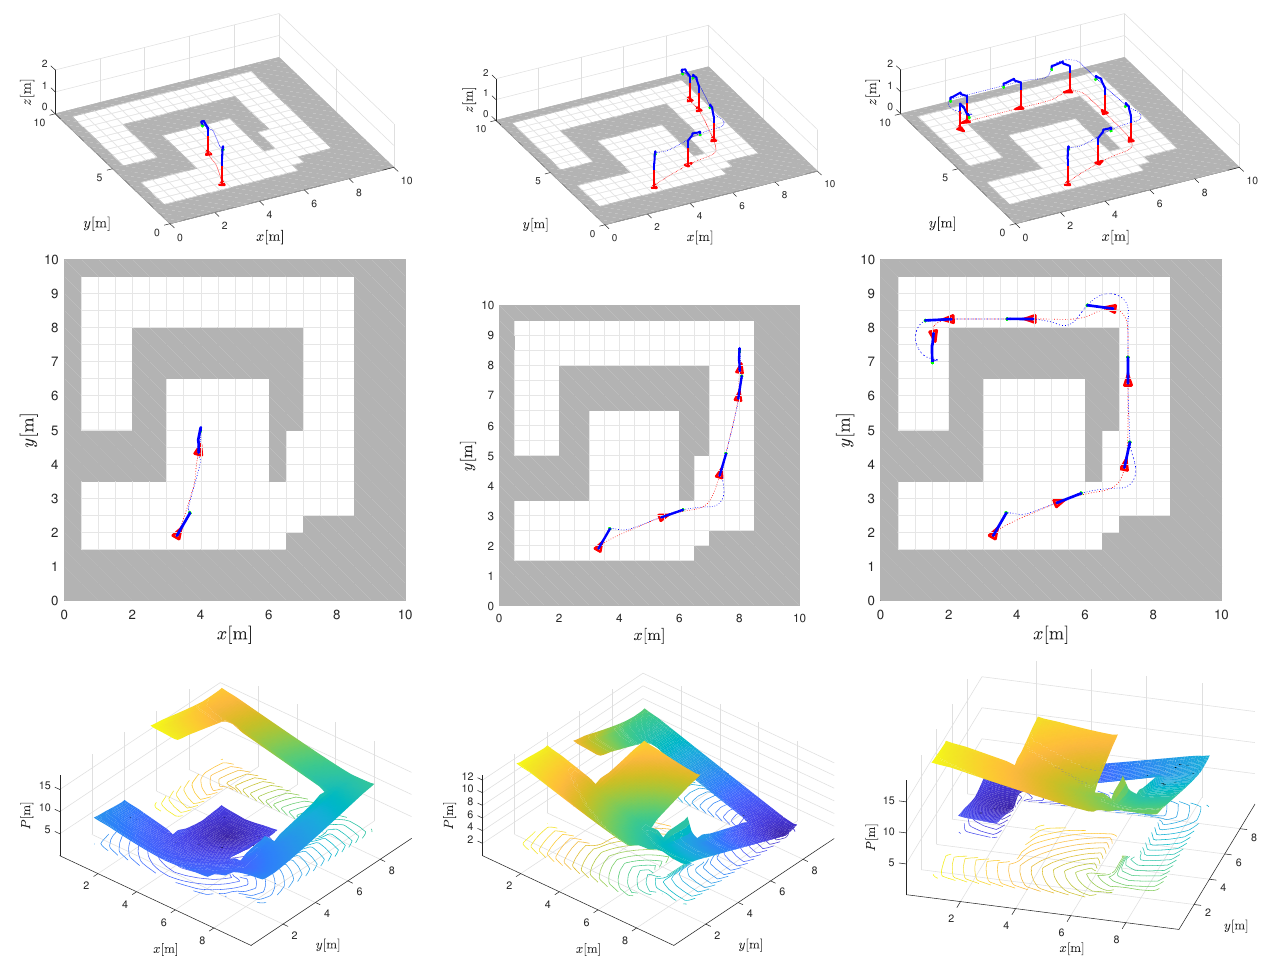
Figure 8. Pose control: three scenarios (shown in columns) of joint arm pose control and base potential field navigation. The first and second rows show the movement of the arm (dotted blue line) and the trajectory of the base (dotted red line). The third row shows the calculated potential navigation with the contours of the same